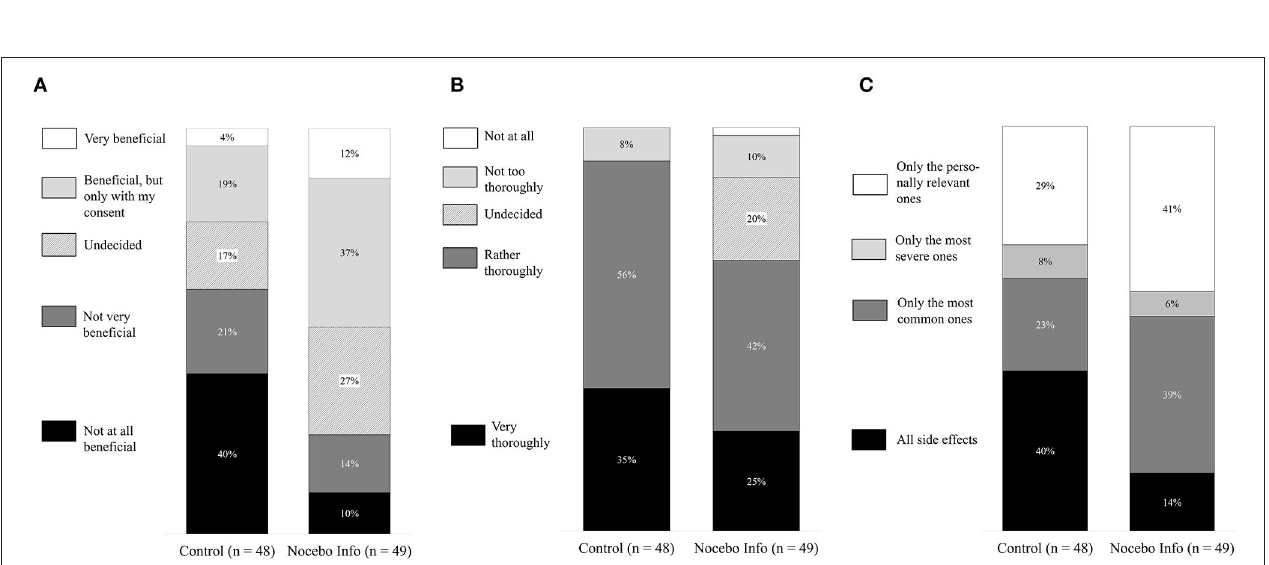
FIGURE 3 | Preferred information disclosure about side effects. Black marked columns indicate the percentage of participants who wish to receive detailed information about the potential side effects. (A) Would you find it beneficial if your practitioner did not inform you about all possible side effects? (B) How thoroughly would you like your practitioner to inform you about possible side-effects? (C) Which side would you like to be informed